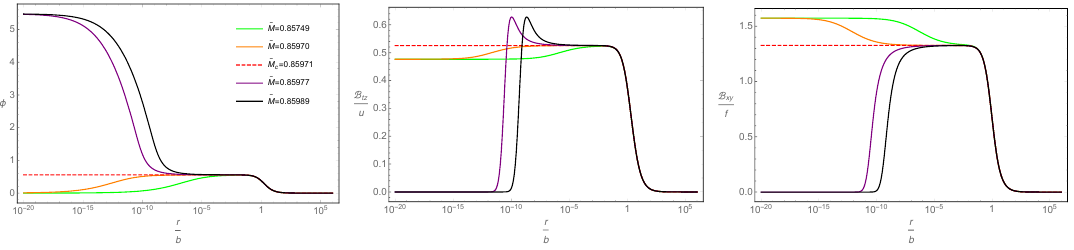
Figure 2 . Bulk profiles for background fields as a function of the radial coordinate in three different phases in the vicinity of critical point. Different colors are for different values of ˆ M = M/b